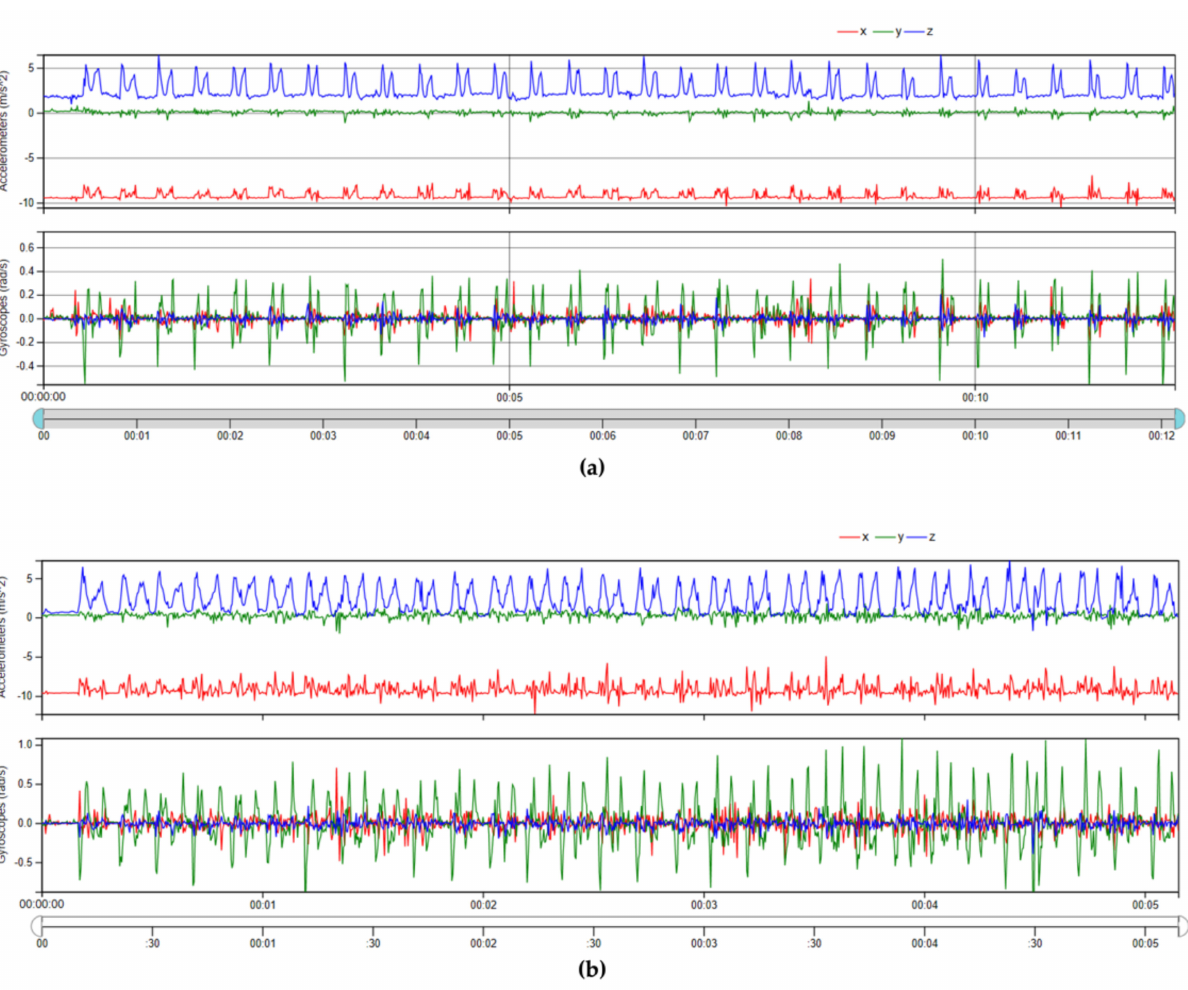
Figure 4. ( a ) Acceleration and angular velocity signals along the 3 axes associated to the NO RISK class, lifting task performed with a LI < 1. ( b ) Acceleration and angular velocity signals along the 3 axes associated to the RISK class, lifting task performed with a LI >